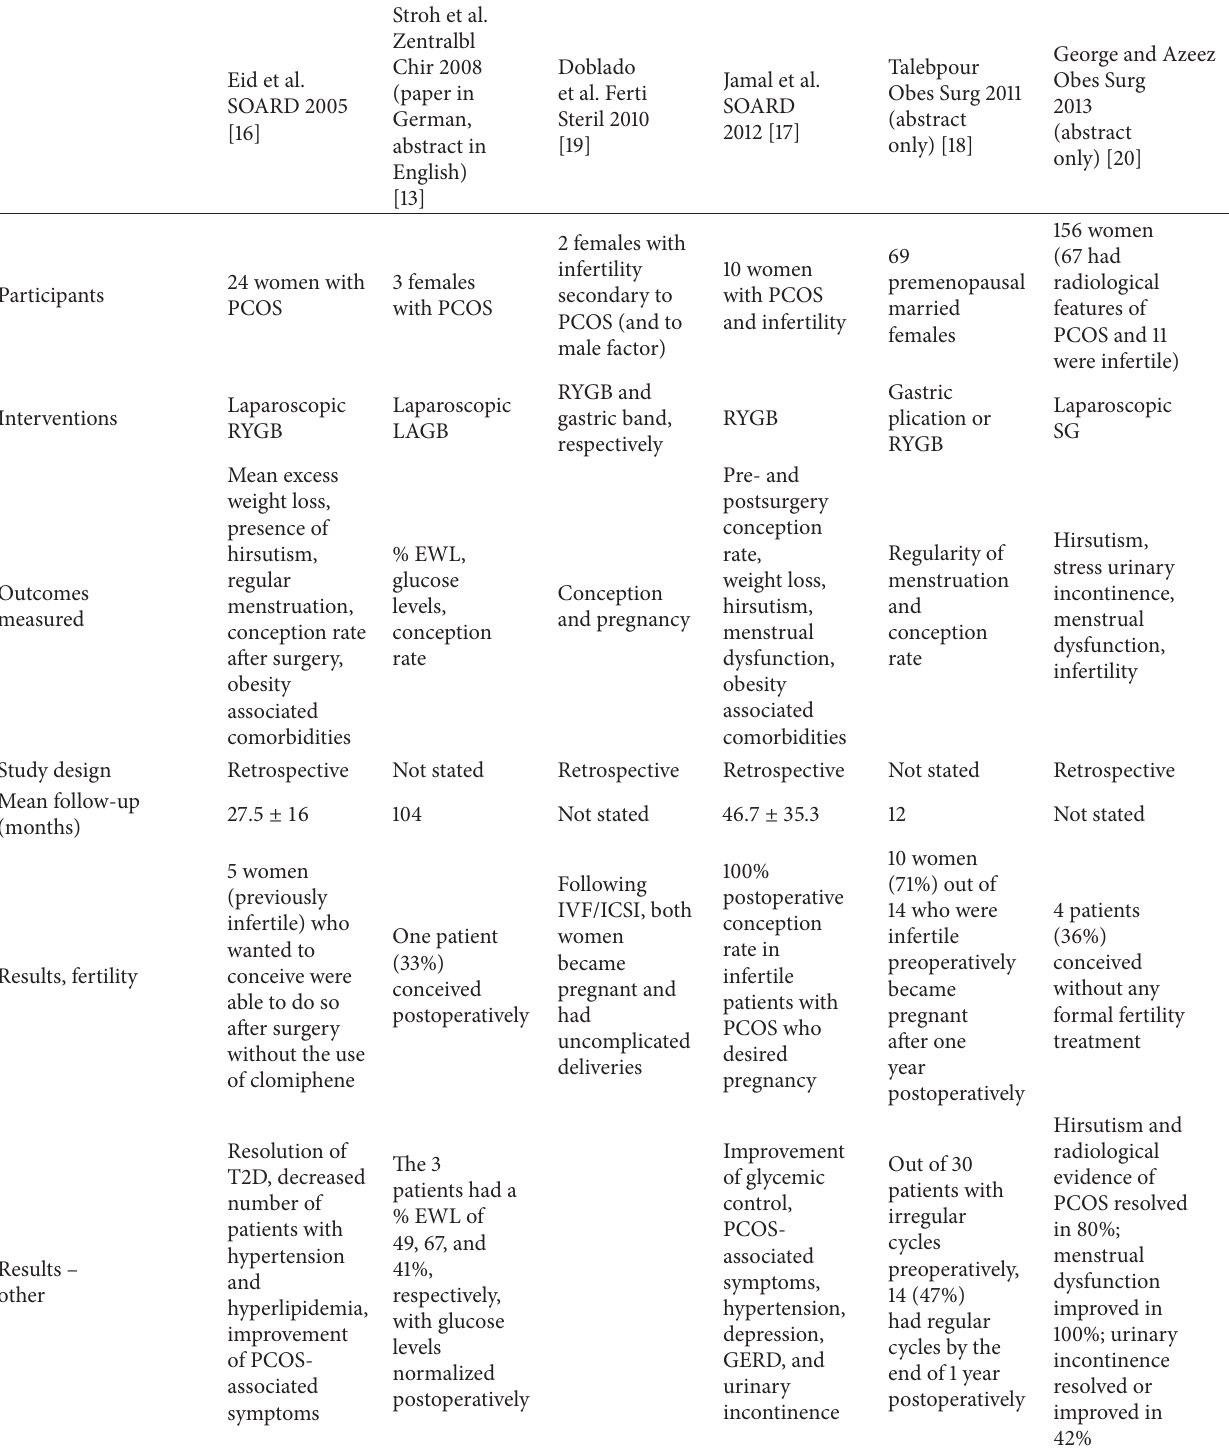
Table 1: Comparison of existing studies about bariatric surgery and female